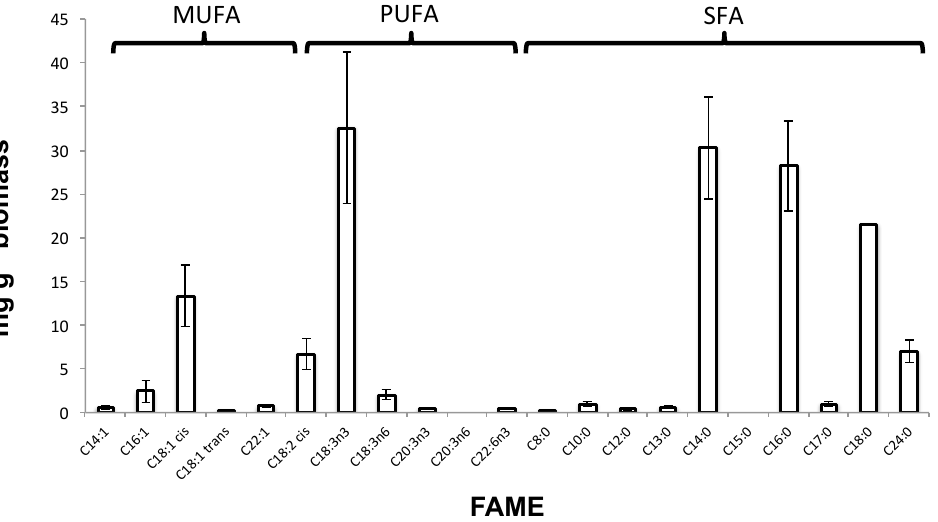
Figure 3. Total FAMEs within biomass sample, characterized as monounsaturated fatty acids (MUFAs), polyunsaturated fatty acids (PUFAs) and saturated fatty acids